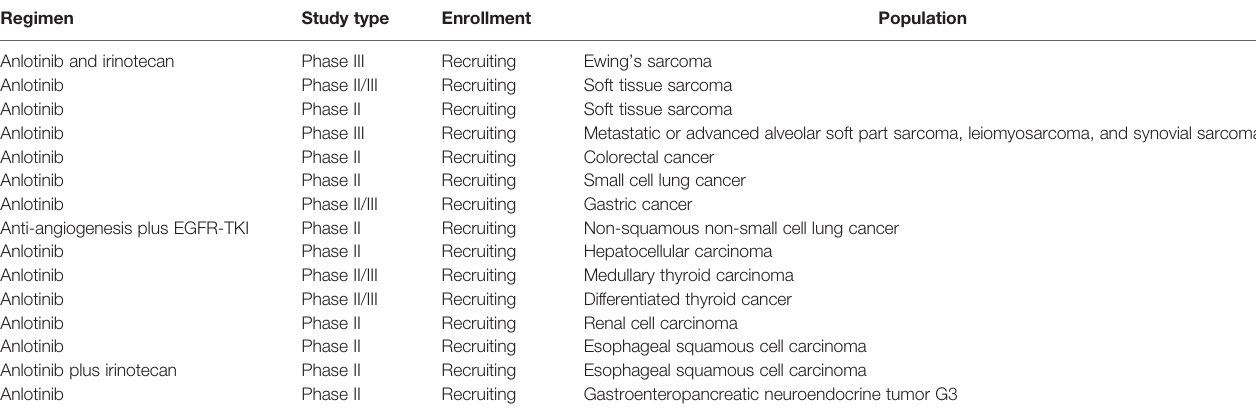
TABLE 2 | Summary of anlotinib clinical trials for multiple cancers.